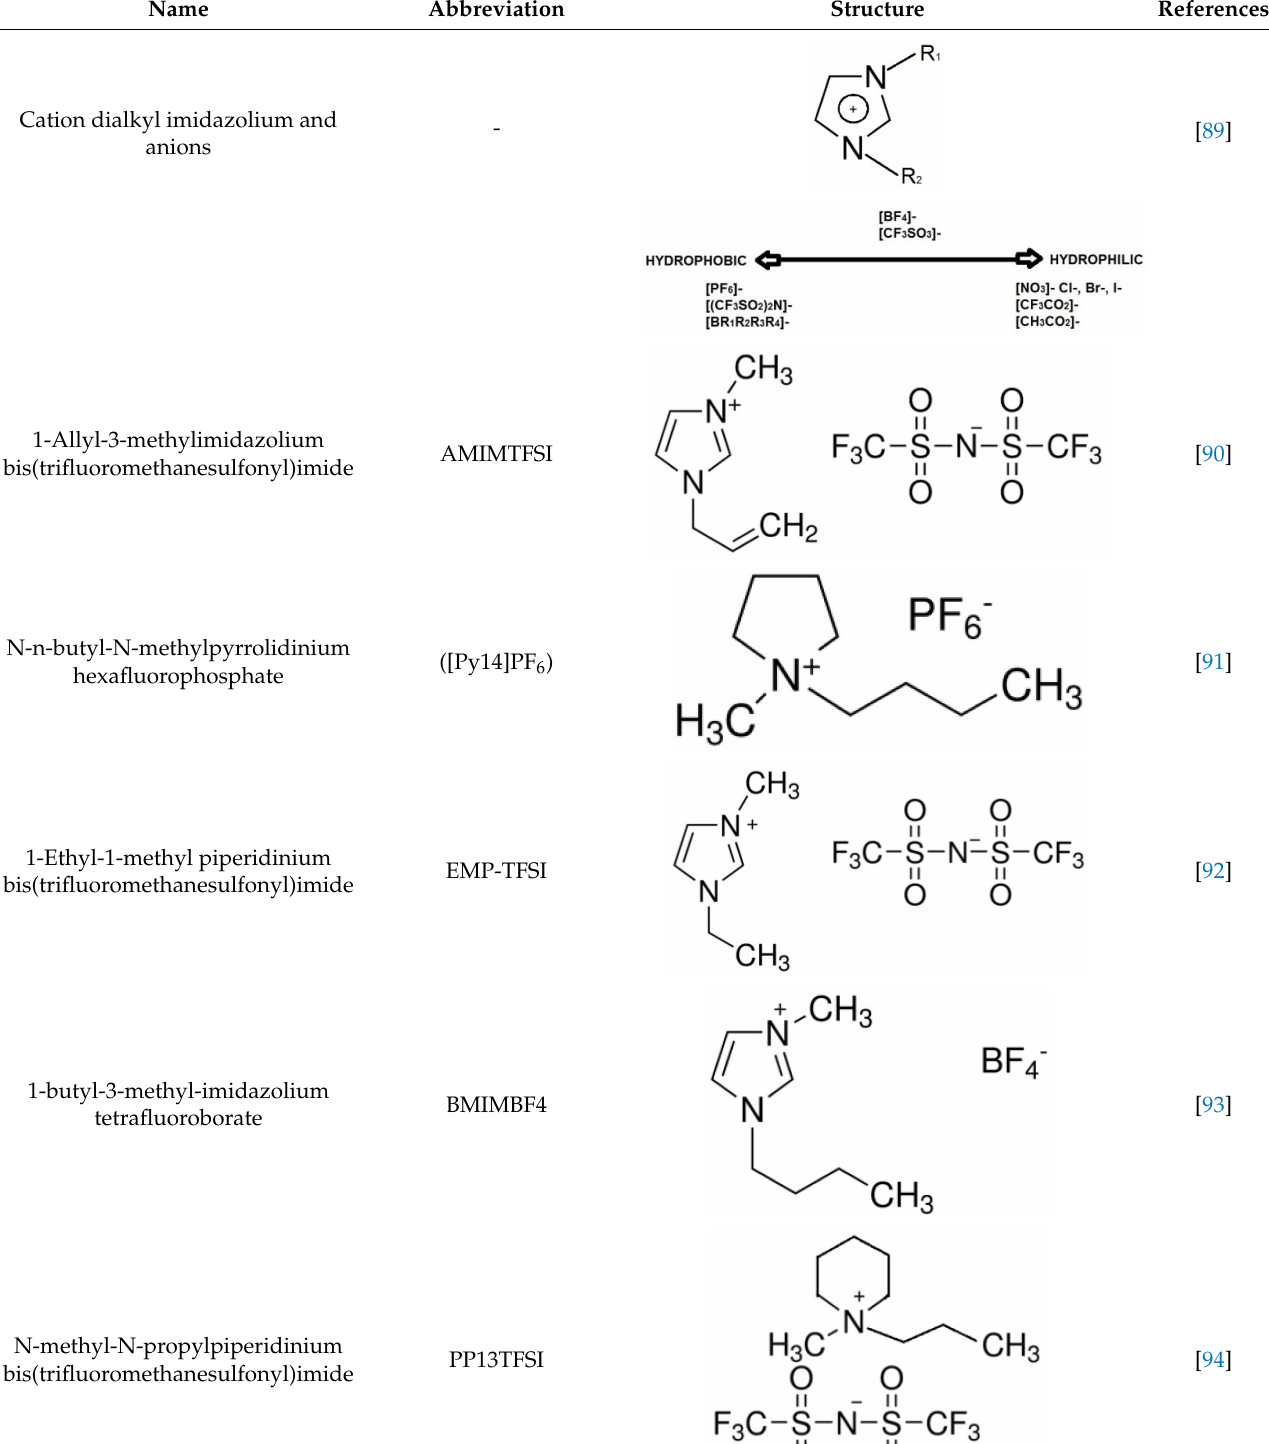
Table 4. Structures of different ionic liquids used to reduce the flammability of